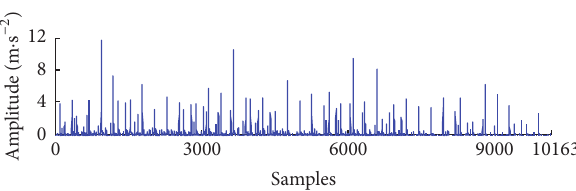
Figure 15: The envelope signal of the resampled signal corresponding to signal in Figure 12(a).